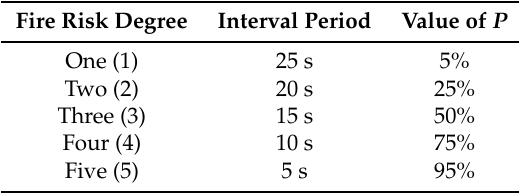
Table 2. System behavior under the different degrees of the Fire